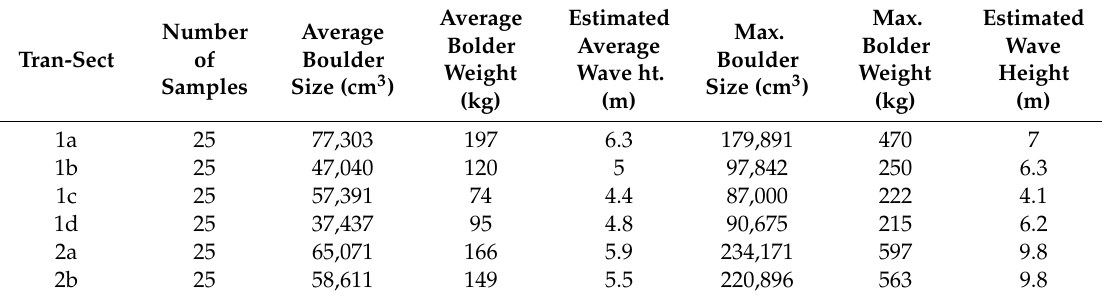
Table 7. Summary data from Tables 1–6 showing maximum boulder size and estimated weight compared to the average values for all boulders (N = 25) from each of transects 1–6 together with calculated values for wave heights estimated as necessary for boulder